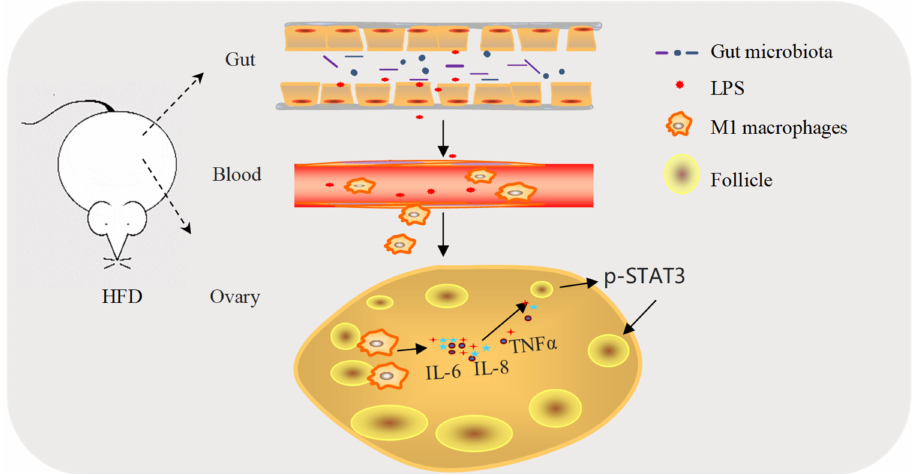
Figure 8. Proposed model for intestinal flora changes induced by a HFD exacerbating activa- tion of primordial follicles through macrophage infiltration and inflammatory factor secretion in mouse